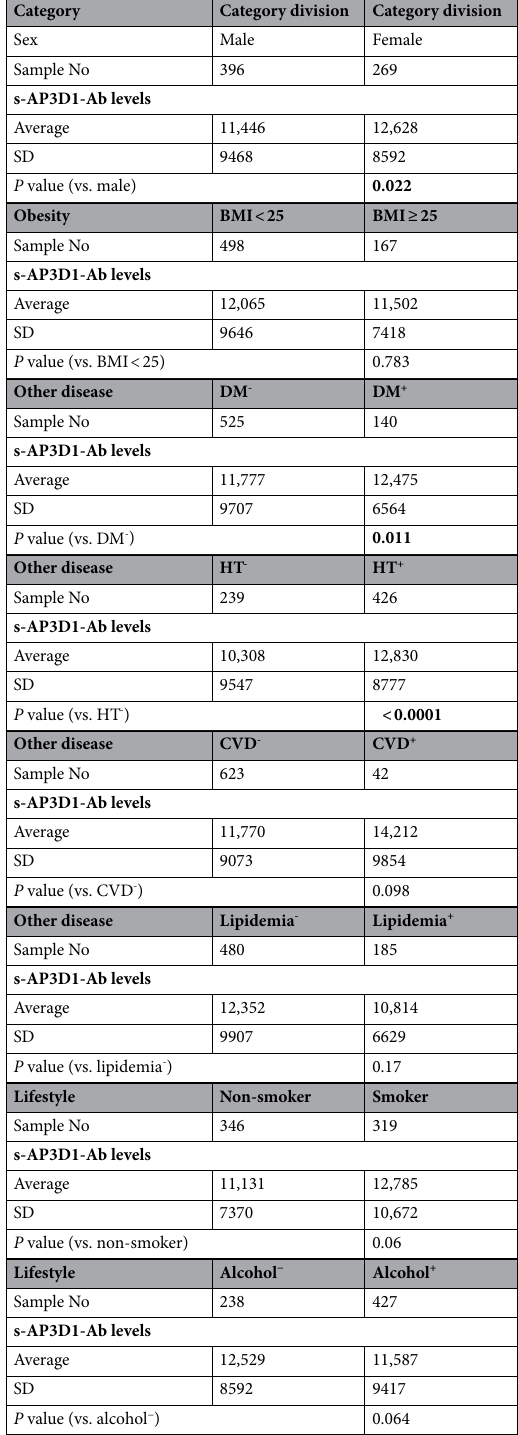
Table 6. Association between s-AP3D1-Ab levels with data from participants in the Sawara Hospital cohort. The participants were divided as follows: sex (male and female), obesity [body mass index (BMI)], presence (+) or absence (−) of DM complications, hypertension (HT), CVD or dyslipidemia, and lifestyle factors (smoking and alcohol intake habits). The s-AP3D1-Ab levels divided into two groups were compared using the Mann– Whitney U test. Sample numbers, averages, and SDs of the counts and the P -values are shown. Significant associations ( P < 0.05) are marked in bold